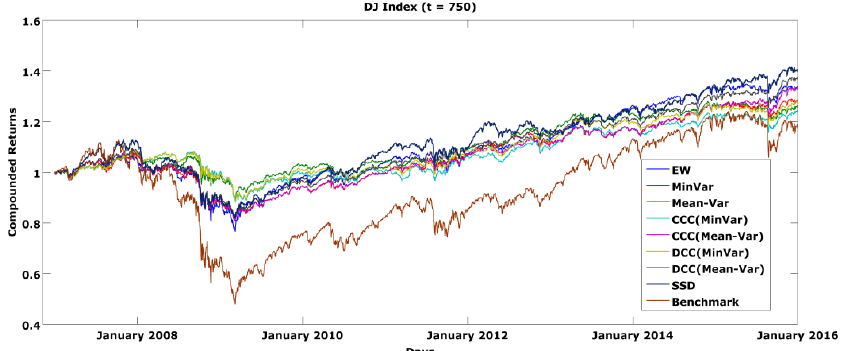
Figure 1. Compounded (on daily basis) returns of portfolios consisting of DJ stocks, t = 750. CCC, Constant Conditional Correlation; DCC, Dynamic Conditional Correlation.